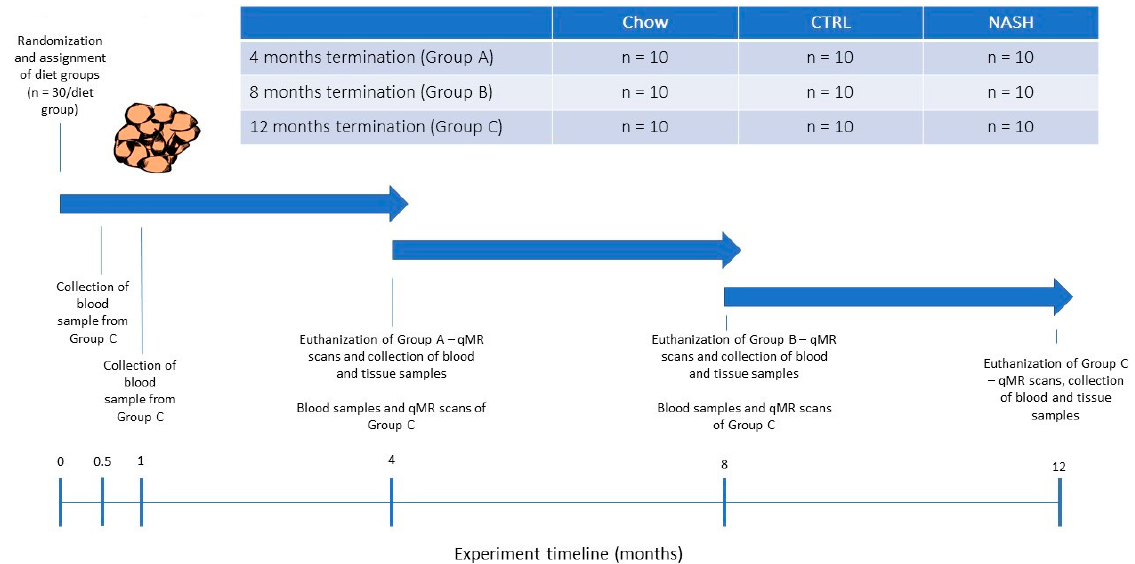
Figure 1. Study Design. At experiment start, male Syrian hamsters (eight to nine weeks old) were randomized to receive either chow diet (Altromin, 1324, Brogaarden), the CTRL-diet (D16010104, Research Diets) or the NASH-diet (D16010102, Research Diets) for four, eight or 12 months (See Group A, B and C in Figure 1). At each time point (four, eight and 12 months), one group/diet group was qMR-scanned, sampled for blood and then euthanized where after tissue samples were collected. Group C (12 months on diet) was additionally sampled for blood at 0.5 and 1 month, to monitor early diet-induced changes in plasma parameters related to dyslipidemia and inflammation/oxidation. qMR: quantitative magnetic